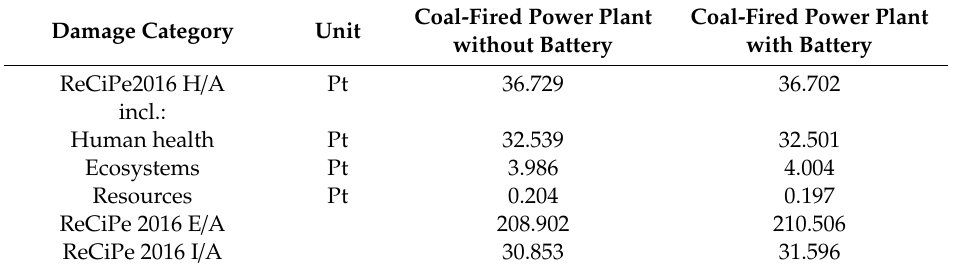
Table 4. Calculated damages to the environment per 1 MWh of electricity (ReCiPe 2016